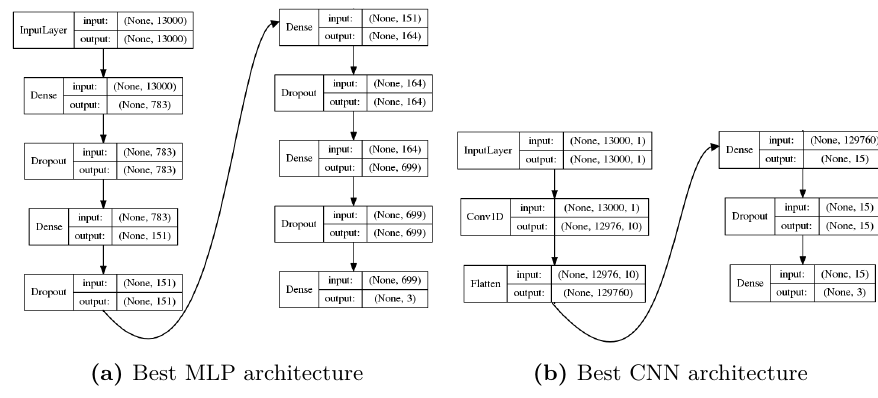
Figure 13: Best neural networks architectures on aligned